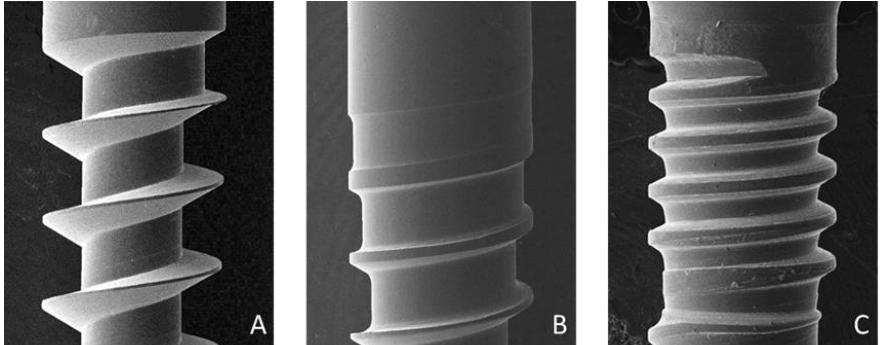
Figure 3. Thread in the neck portions of microimplants were magnified by a scanning electron microscope (Hitachi SU8010, Japan). From left to right as follow: Type ( A ) (no microthread neck), Type ( B ) (no microthread neck), and Type ( C ) (microthread neck).